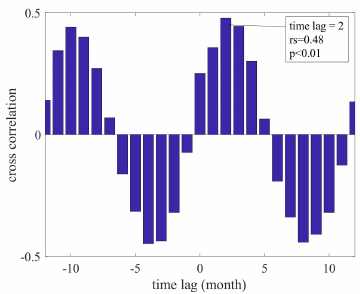
Figure 9. Correlations between the temperature and precipitation time series changes with changing time lag. The correlations are computed at the 99% confidence levels.